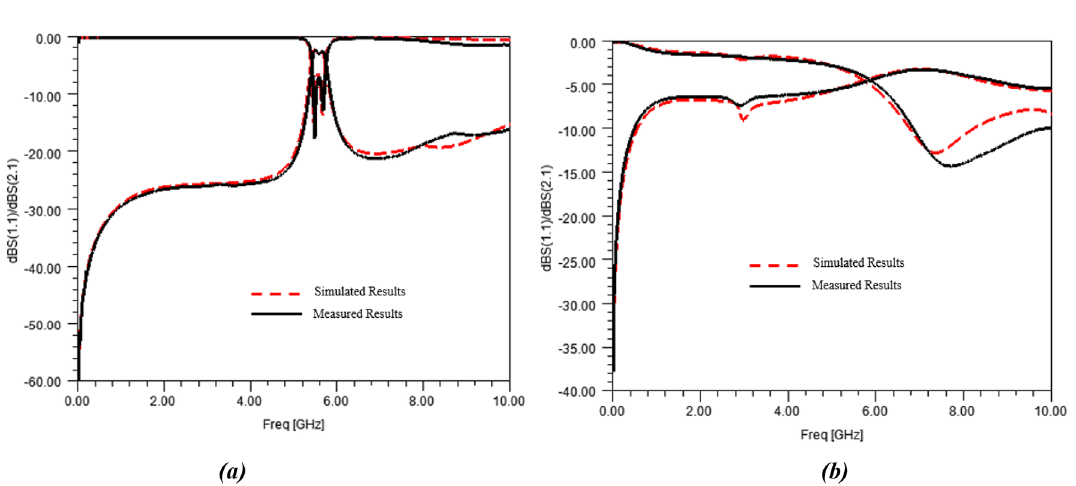
Figure 13. Measured and retrofitted (EM simulations) S-parameters of the sensor with the container filled in with ( a ) air and with ( b )